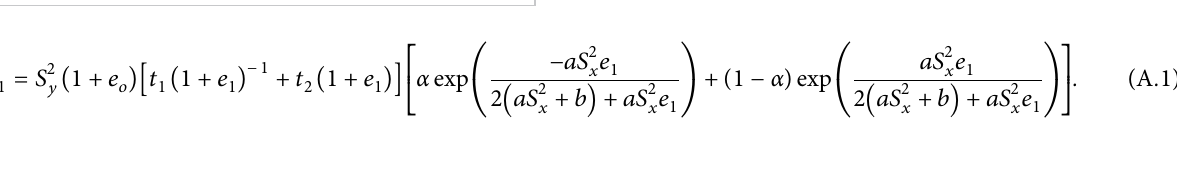
Table 13: PRE of the existing and proposed class of estimators of Population-IV at ρ ∗ Strategy